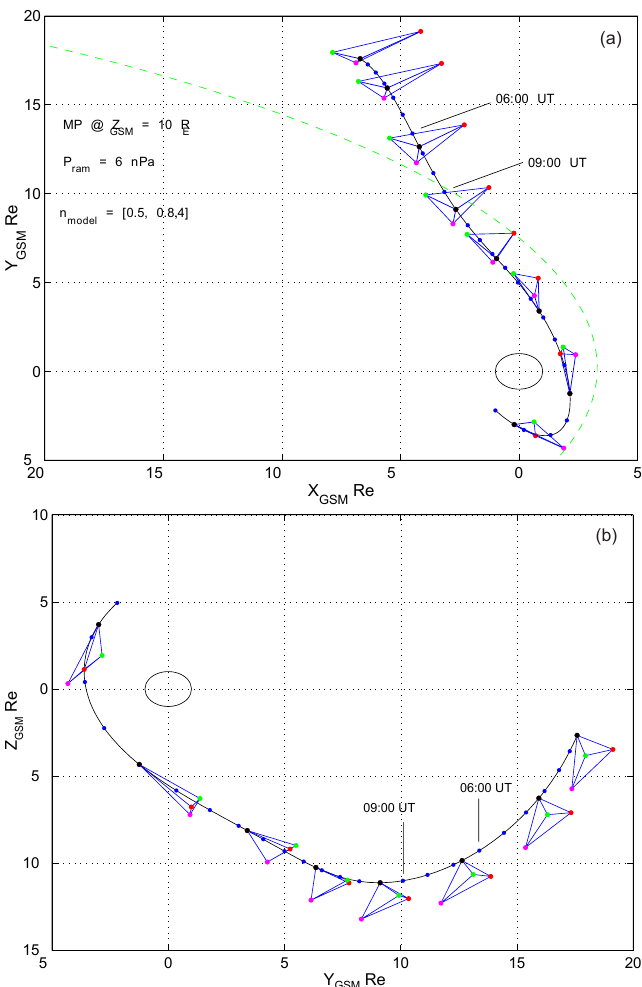
Fig. 2. (a) Projected plot of the Cluster orbit (spacecraft 1) into X , Y GSM coordinates and model magnetopause location, fitted to the crossing near 09:00 UT. The configuration of the spacecraft is shown at intervals along the orbit, with the separations scaled by a factor of 20. As can be seen by Fig. 2b, spacecraft 2 and 3 lie almost parallel to the X , Y plane, with spacecraft 1 above and spacecraft 4 below. The magnetopause is shown as a cut through the intersection with the orbit. The model normal and the ram pressure used is also shown (b) As for Fig. 2a, but in the Y , Z GSM